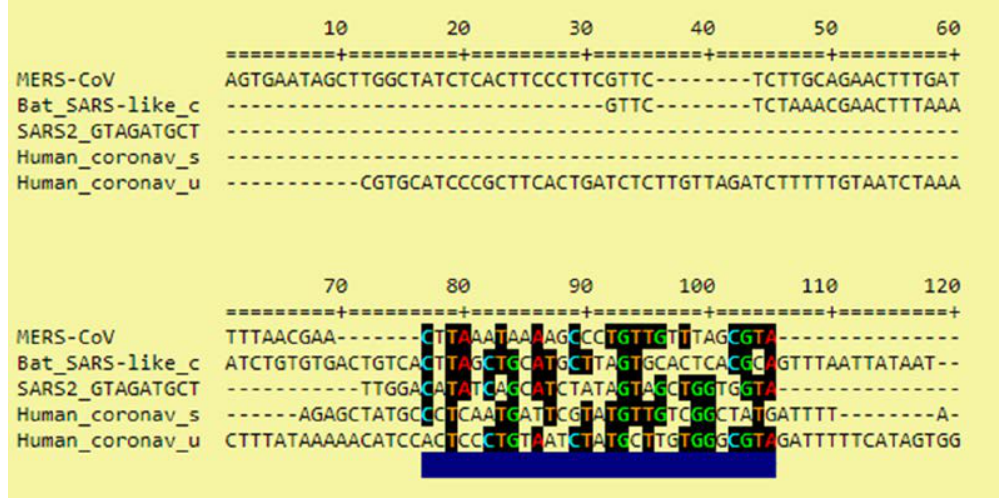
Fig. 1. Nucleotide sequence similarities among